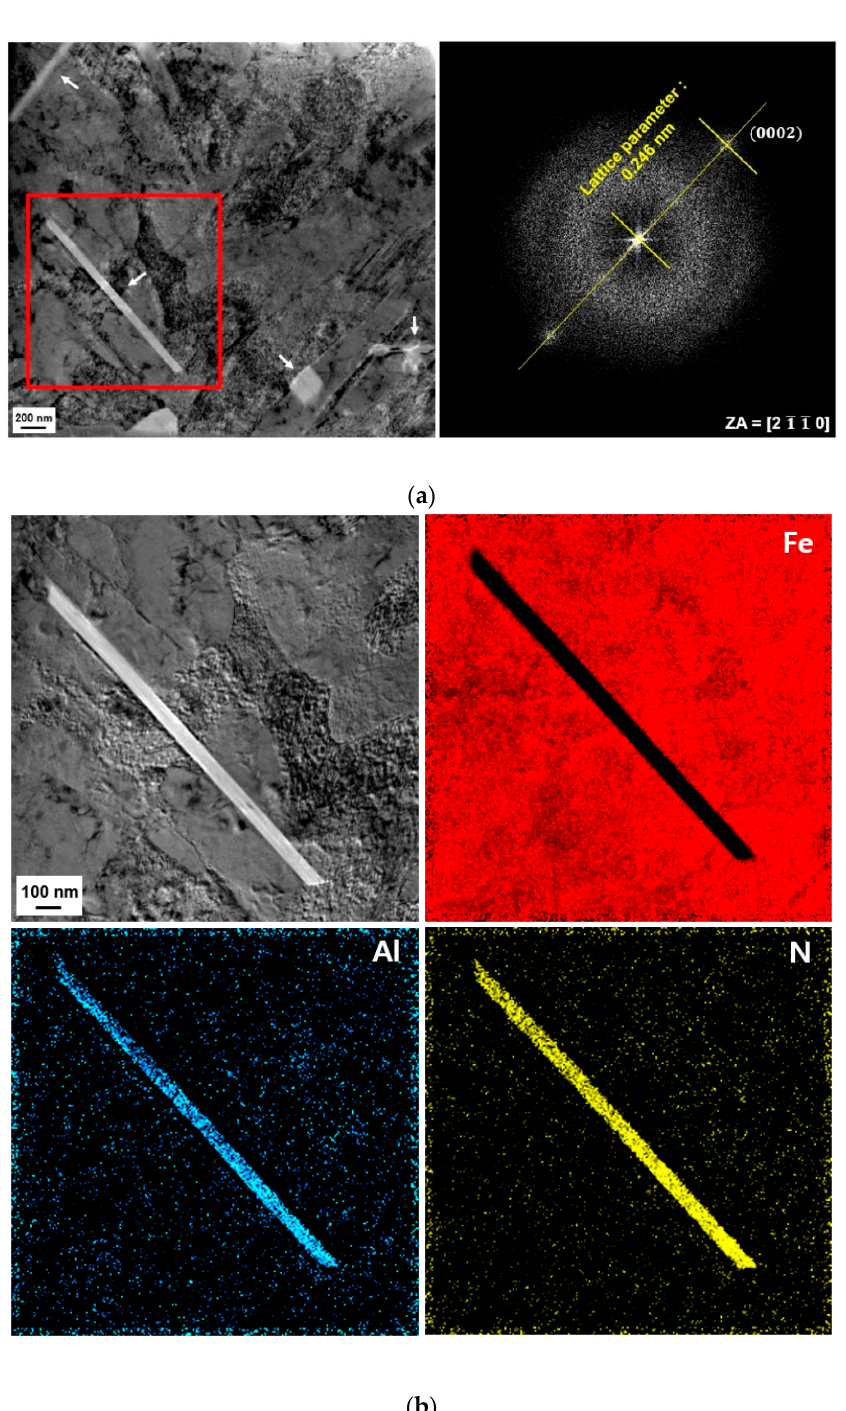
Figure 8. ( a ) Magnified TEM image at the red box in figure ( a ) and ( b ) corresponding Fe, Al, and N elemental distribution maps obtained from the electron energy loss spectroscopy (EELS) analysis.